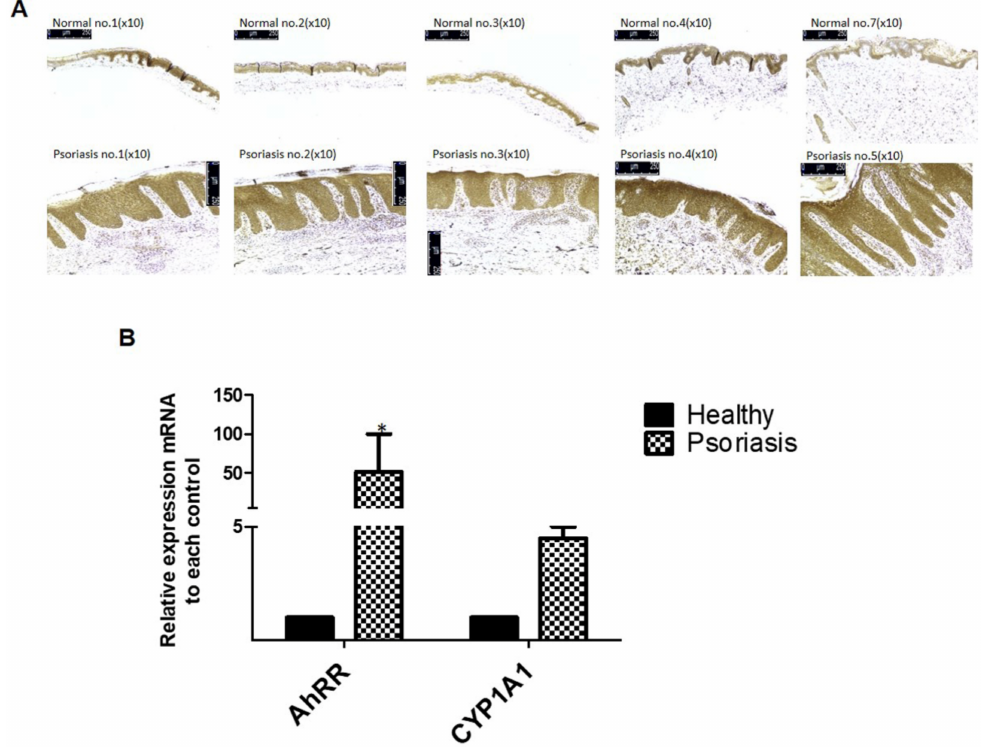
Figure 1. Expression of AhRR in healthy human skin and lesional skin of psoriasis. ( A ) Immuno- histochemical staining was performed for AhRR on healthy and psoriasis epithelial skin samples. Positive cells appeared brown (for all objective X10/ n = 5 groups). ( B ) Relative expression of AhRR and CYP1A1 target genes was confirmed in healthy and psoriasis skin samples. The control group indicated healthy people, and the test group indicated psoriasis patients. Values are means ± SEM. Statistical significance of differences between groups was assessed by one-way analysis of vari- ance (ANOVA) for factorial comparisons and by Tukey’s multiple comparison tests for multiple comparisons. All experiments of at least five donors each per condition are shown. * p < 0.05 vs. healthy